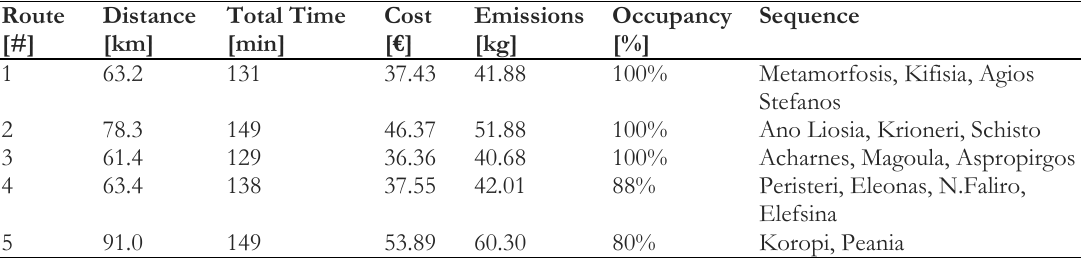
Table 7. Vehicle routing – SS2